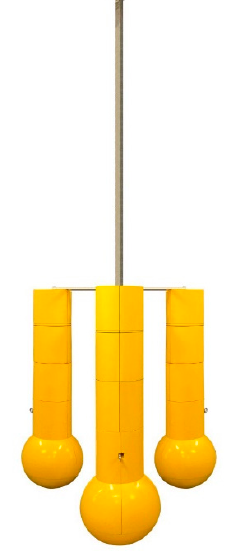
Figure 1. Main dimensions of the reduced scale model.